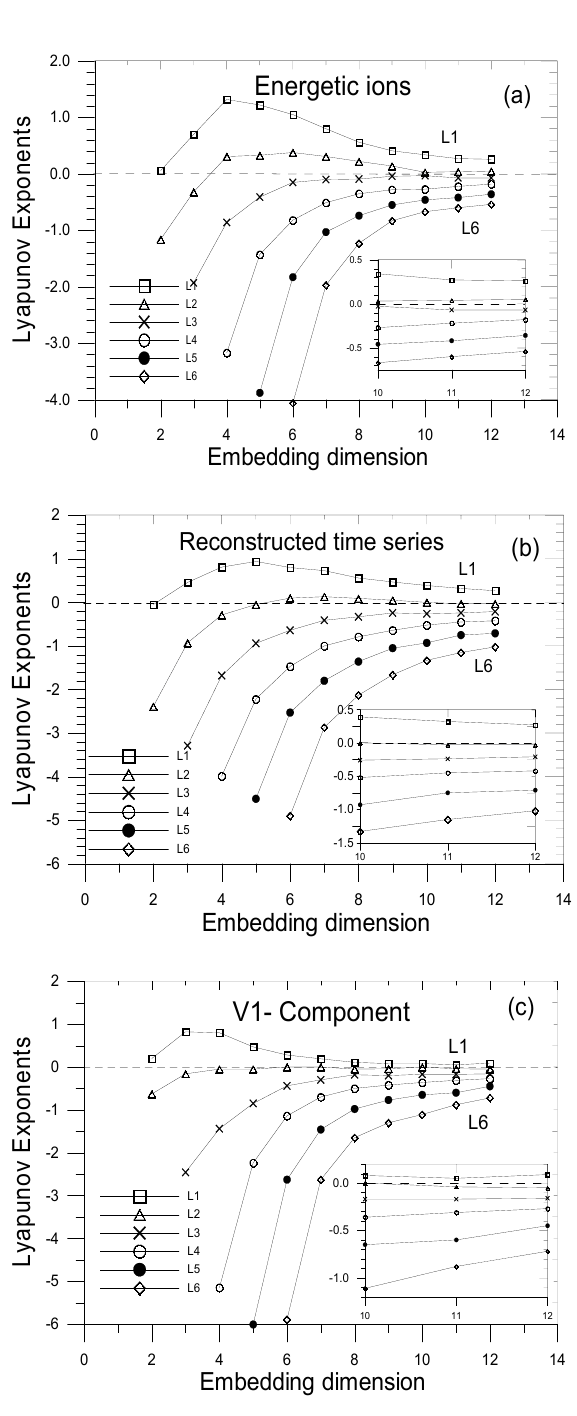
Figure 1 Fig. 1. (a) The spectrum of the first six Lyapunov exponents es- timated for the energetic ions, as a function of the embedding di- mension m . (b, c) The same with (a) but for the reconstructed and V 1 -component time series of the energetic ions’ time